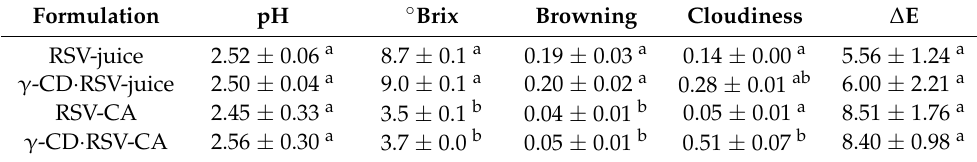
Table 1. Physicochemical characteristics of formulated juices and citric acid solutions. Formulation pH ◦ Brix Browning Cloudiness ∆ E